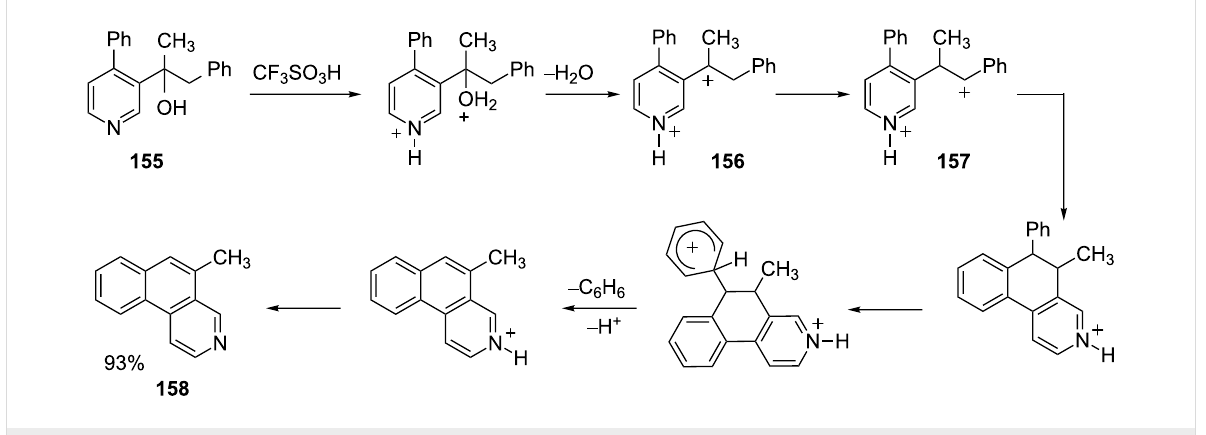
Scheme 31: Mechanism of aza-polycyclic aromatic compound formation.